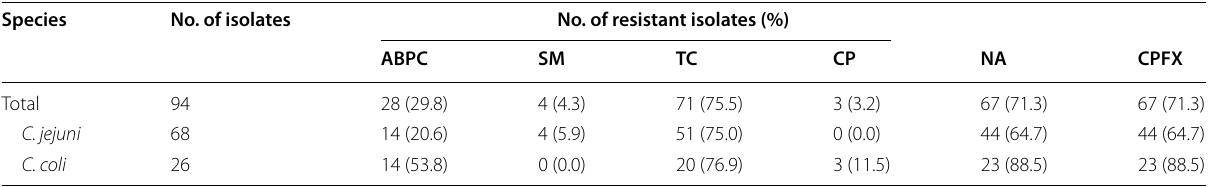
Table 1 Antimicrobial resistance in C. jejuni and C. coli